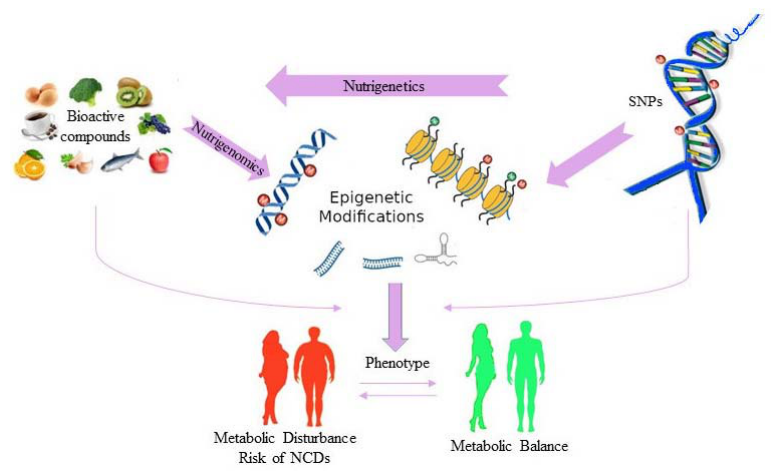
Figure 1. Interactions among genes, diet and human health.